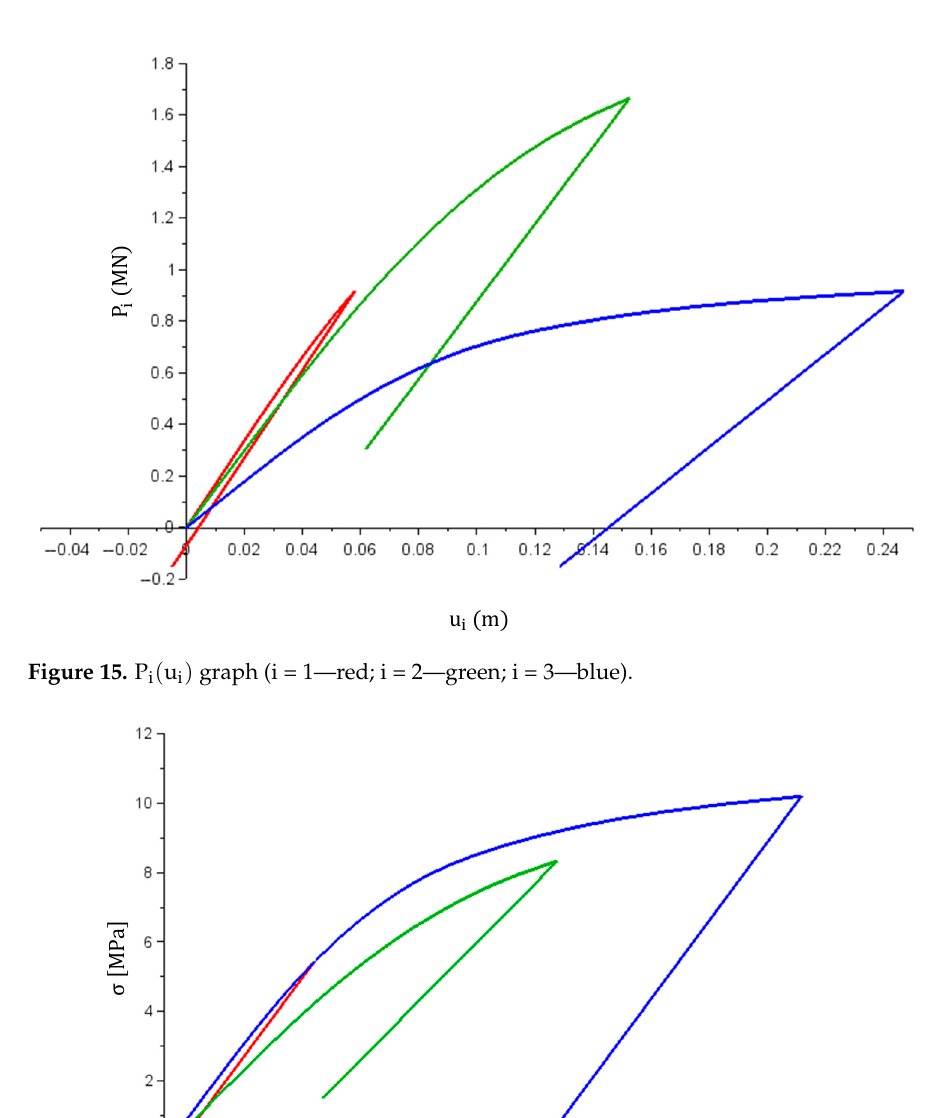
Figure 16. σ (cid:2919) (ε (cid:2919) ) graph (i = 1—red; i = 2—green; i = 3—blue). Figure 16. σ i ( ε i ) graph (i = 1—red; i = 2—green; i =